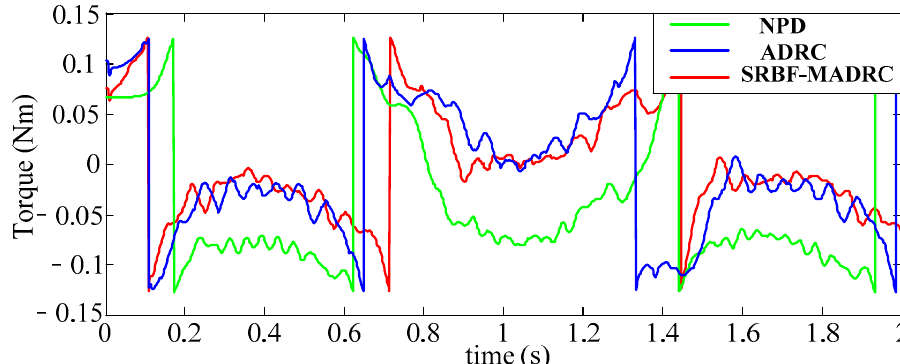
Figure 14. Output torque curves of three algorithms.